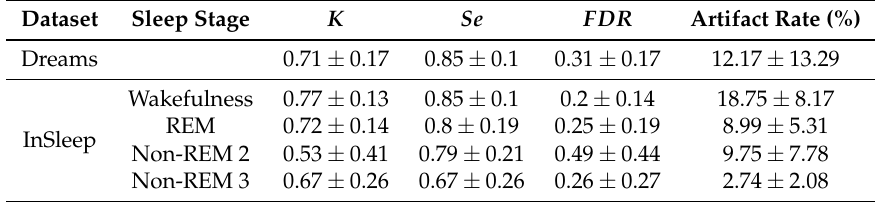
Table 4. Performance of RPs artifact detection with a 2-s epoch length.